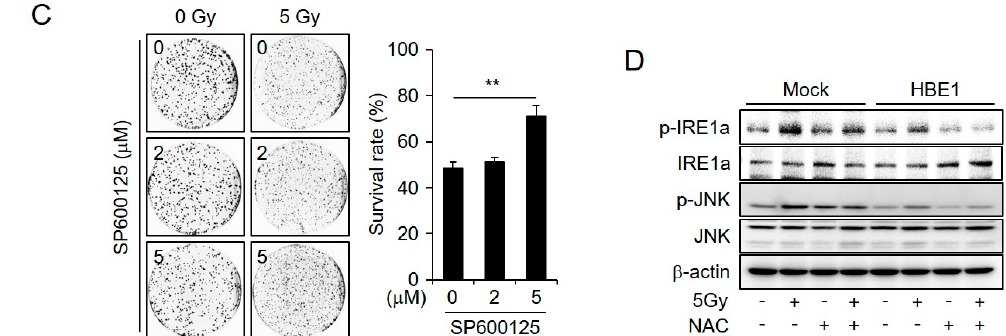
Figure 4. Enrichment of HBE1 levels decreases the radiation-induced activation of Jun amino-terminal kinase (JNK) and endoplasmic reticulum (ER) stress. After the transfection of SW480 cells with a flag-tagged HBE1-overexpression or mock vector in the presence or absence of radiation (5 Gy), the activation of JNK, ER stress-related proteins, and colony formation ability were measured by immunoblot analysis and a clonogenic assay. ( A ) Lysates were analyzed by western blotting to determine the activation level of p-JNK, total JNK, and FLAG for early (left panel) and late (right panel) timepoints after radiation exposure (5 Gy). ( B ) The activation of ER stress signaling proteins was assessed. β -actin was used as a loading control. ( C ) Following exposure to irradiation (5 Gy) in the presence or absence of the JNK inhibitor SP600125 for the indicated doses, cell survival rate was measured using a clonogenic assay ** p < 0.01, and compared to that in untreated cells. ( D ) After transfection with an HBE1-overexpression or mock vector in the presence or absence of radiation (5 Gy) exposure and ROS scavenger treatment, the inhibition of radiation-induced ER-stress by N-acetyl cysteine (NAC; 10 mM) was analyzed by western blotting. β -actin was used as a loading control. The phosphorylation of IRE1a and JNK was measured by pretreating cells with NAC before exposure to 5 Gy of